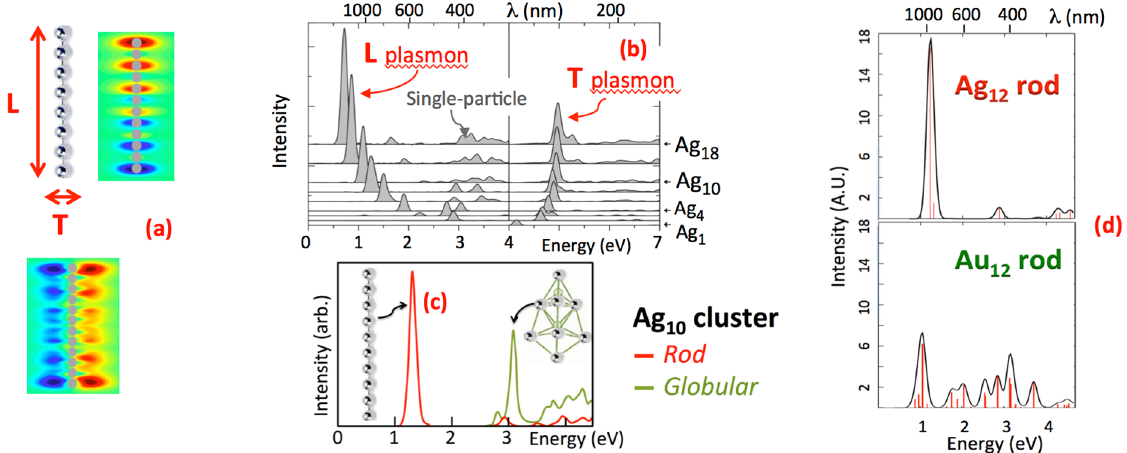
Figure 4. Sensitivity of cluster absorbance spectra to the cluster shape, size and composition. ( a ) An atomic silver rod, with the 2 types of collective excitations illustrated by their electron density profiles (color). Valence electrons slosh longitudinal to the rod in the “L” plasmon, and transverse to the rod in the “T” plasmon; ( b ) These L and T collective excitations dominate the optical absorbance spectra of Ag rods. Much weaker transitions are single particle-like. (Adapted with permission from reference [50]); ( c ) When the same number of Ag atoms is rearranged from a rod (red) into a globule (green), the absorbance shifts to higher energy and becomes more scattered. (Adapted with permission from reference [51]); ( d ) Calculated absorbance spectra of Ag 12 (top) and Au 12 (bottom) rod clusters. The congested spectrum for Au 12 arises from mixing of valence electron and d orbital transitions. (Adapted with permission from reference